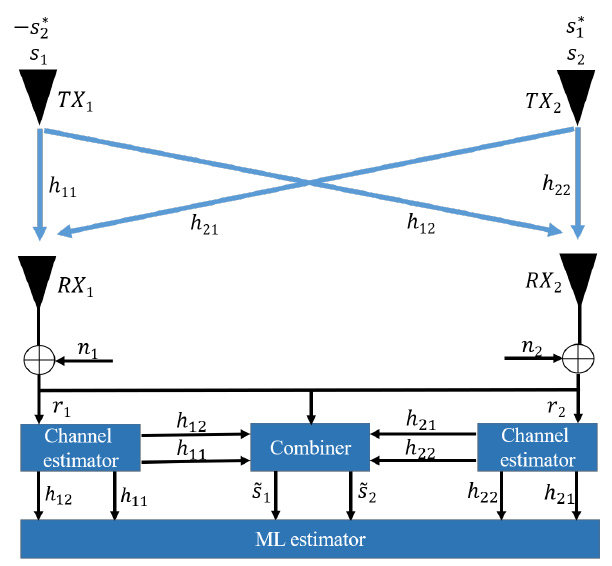
Figure 1. Illustration of 2 × 2 Alamouti space time coding (STC).